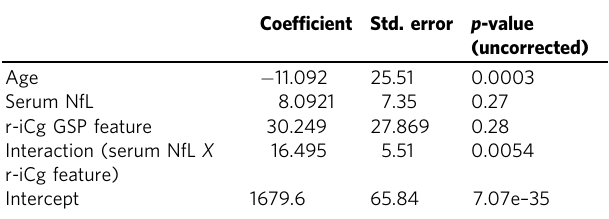
Table 4 Statistics for moderation analysis for interaction between GSP feature from right isthmus cingulate and right amygdala volume for ExPro